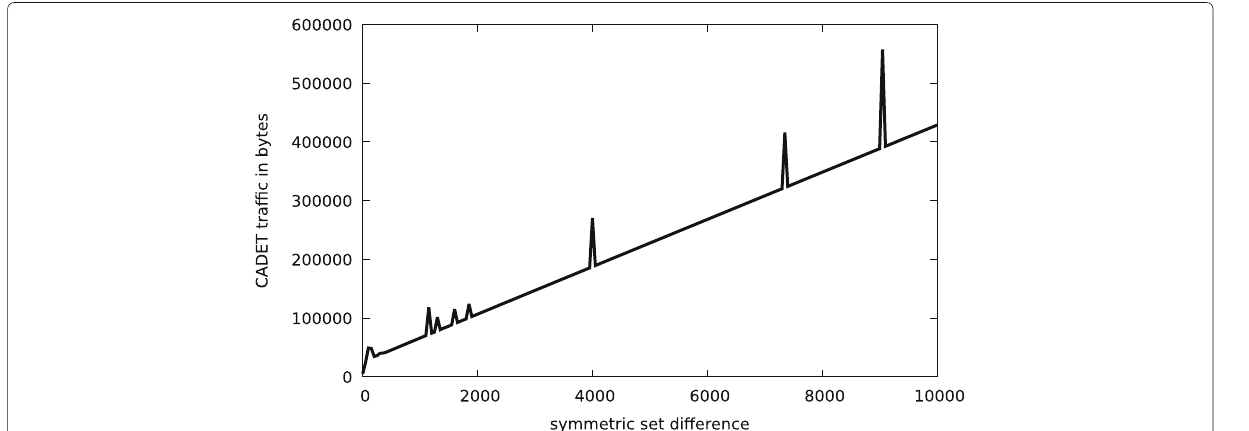
Fig. 4 CADET traffic for the SET service in relation to symmetric difference. Average over 50 executions